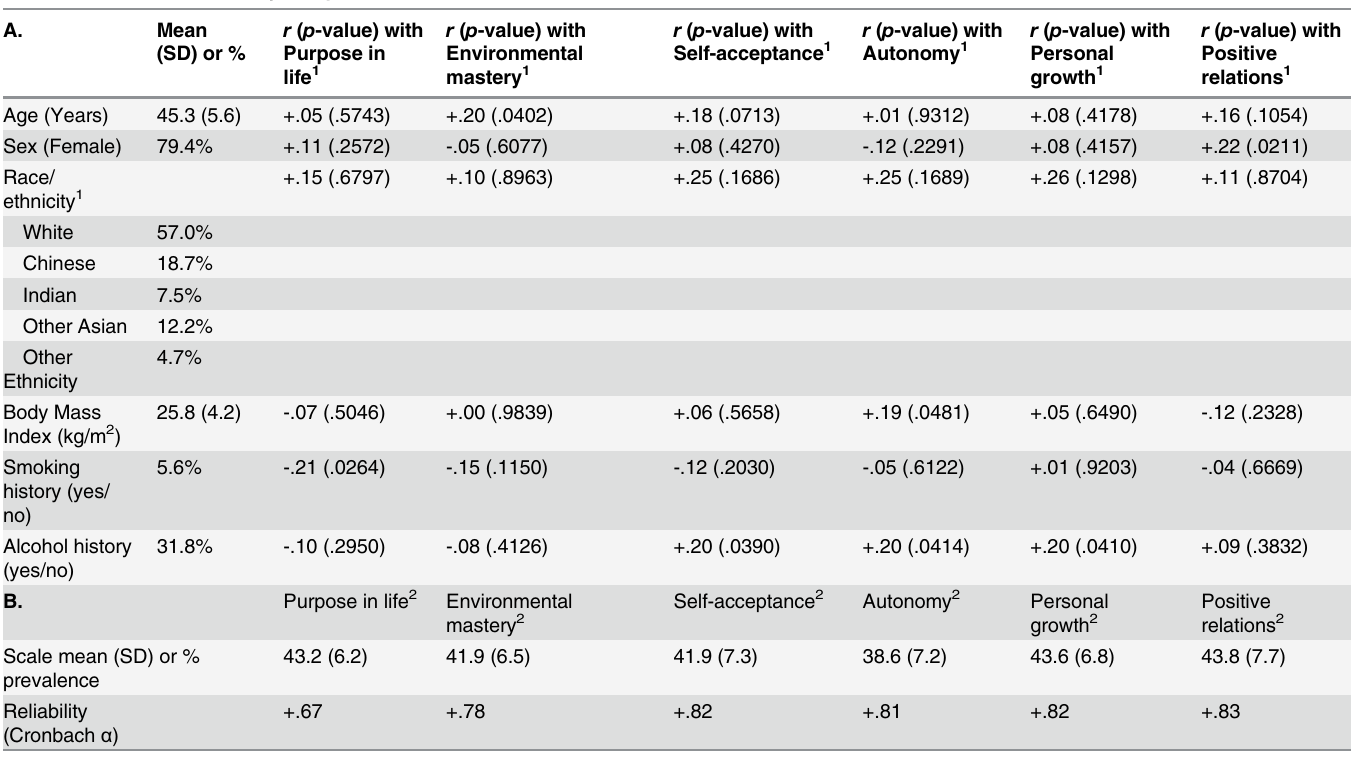
Table 4. Generalization Study Sample